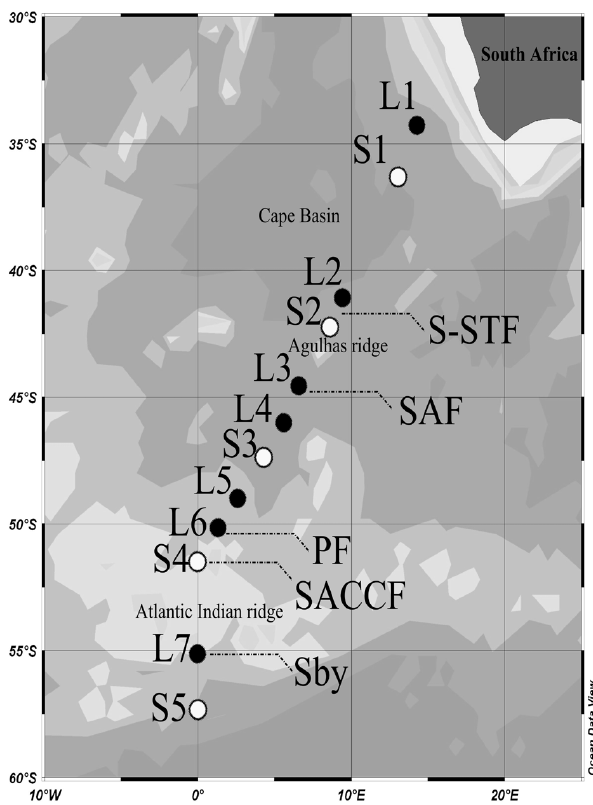
Fig. 1. Location of the stations sampled for dissolved cobalt (DCo) and its organic speciation during the MD166 BONUS- GoodHope cruise. Black circles designate the LARGE stations and white circles the SUPER stations. The positions of fronts are also shown, with the southern branch of the subtropical front (S- STF; ∼ 42 ◦ 2 0 S), the subAntarctic front (SAF; 44 ◦ 2 0 S), the polar front (PF; 50 ◦ 22.4 0 S), the southern ACC front (SACCF; ∼ 51 ◦ 52 0 S) and the southern boundary of the Antarctic Circumpolar Cur- rent (SBdy; ∼ 55 ◦ 54.3 0 S). From their geographical positions, stations L1, S1 and L2 were in the subtropical domain (STD), S2 and L3 were, respectively, on the northern and southern side of the subantarctic zone (SAZ), stations L3, L4, S3 and L5 were within the polar frontal zone, station L6 was on the northern flank of PF, S4 was on the SACCF, station L7 was at the SBy, and station S5 was in the northern branch of the Weddell